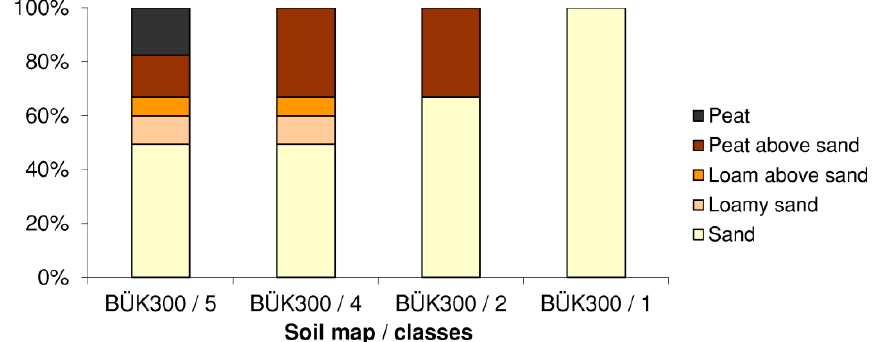
Figure 2. Fraction of the soil types of the soil map BÜK300 for the different aggregation levels.